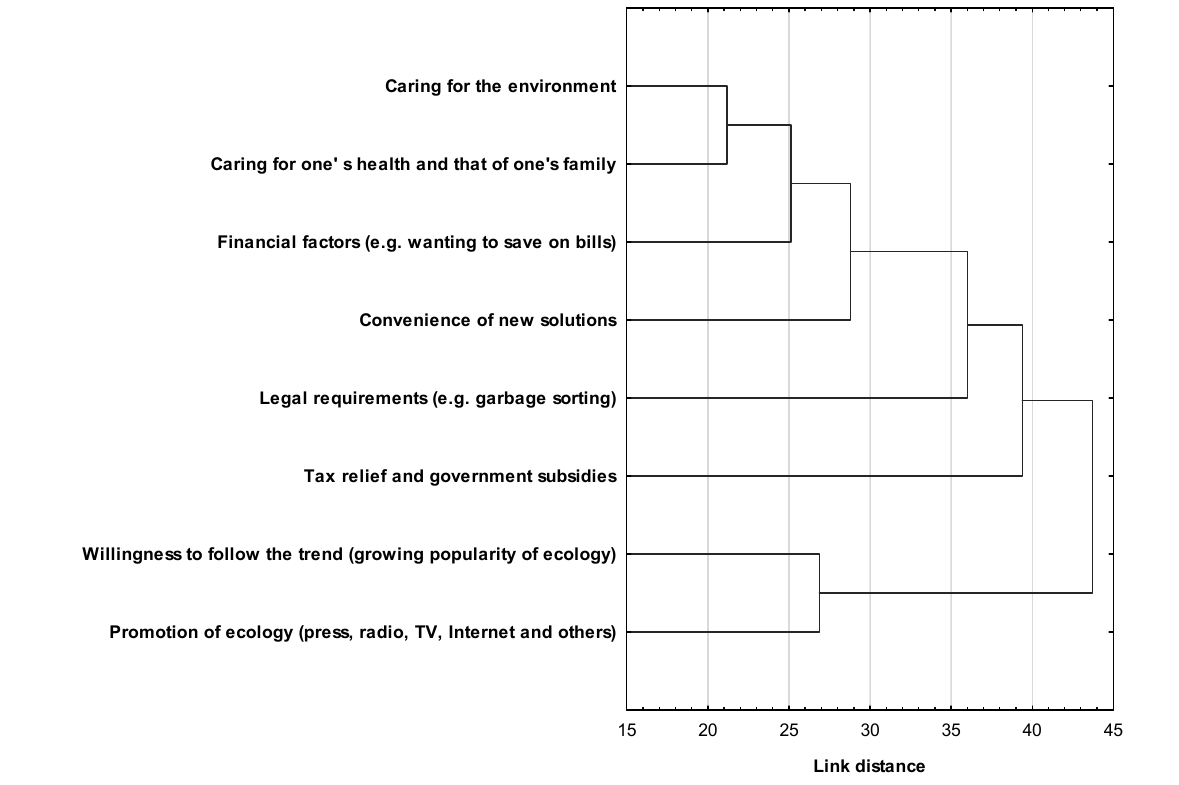
Figure 2. Dendrogram obtained for individual motivational factors in terms of the degree of motivation of the respondents to undertake pro-ecological behavior (results of cluster analysis using agglomeration). Table 6. Factors limiting respondents in undertaking pro-ecological